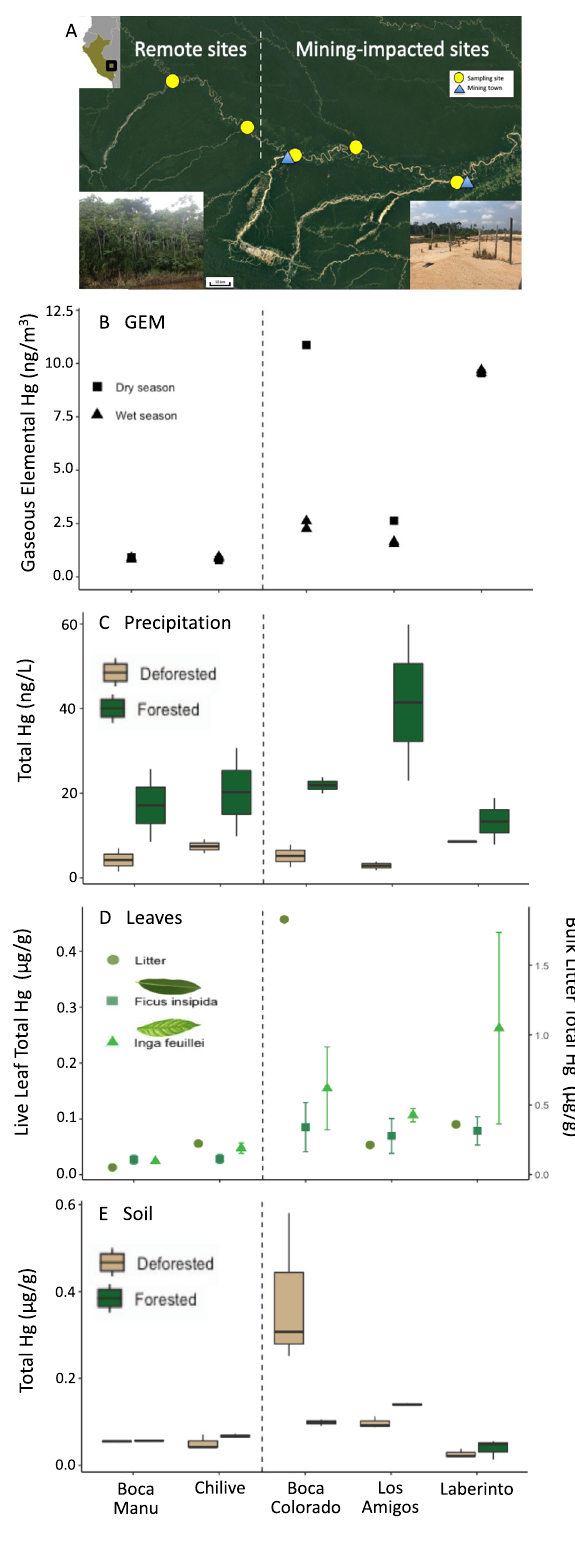
Fig. 2 Concentrations of mercury in depositing materials and sur fi cial soil in Madre de Dios, Peru. A Map of the fi ve sampling sites shown as yellow circles. Two sites (Boca Manu, Chilive) are located in areas remote from artisanal gold mining, and three sites (Los Amigos, Boca Colorado, and Laberinto) are located in mining-impacted areas, with mining towns shown as blue triangles. The insets show a typical forested remote site and deforested mining-impacted site. In all fi gures, the dashed line represents the demarcation between the two remote sites (on the left) and the three mining-impacted sites (on the right). B Gaseous elemental mercury (GEM) concentrations at each site for the 2018 dry ( n = 1 independent sample for each site; square symbol) and wet ( n = 2 independent samples; square symbol) seasons. C Concentration of total mercury in precipitation collected in forested (green boxplots) and deforested (brown boxplots) areas during the 2018 dry season. For all boxplots, the line represents the median value, the box shows Q1 and Q3, and the whiskers denote 1.5 times the interquartile range ( n = 5 independent samples for each forested site, n = 4 independent samples for each deforested site). D Concentration of total mercury in leaves collected during the 2018 dry season from the canopy of Ficus insipida and Inga feuillei (left axis; dark green square and light green triangle symbols, respectively) and as bulk litter on the ground (right axis; olive green circle symbol). Values are shown as mean and standard deviation ( n = 3 independent samples for live leaves for each site, n = 1 independent sample for litter). E Concentration of total mercury in sur fi cial soils (top 0 – 5 cm) collected during the 2018 dry season ( n = 3 independent samples for each site) in forested (green boxplots) and deforested (brown boxplots) areas. Data for other seasons are shown in Figs. S1 and